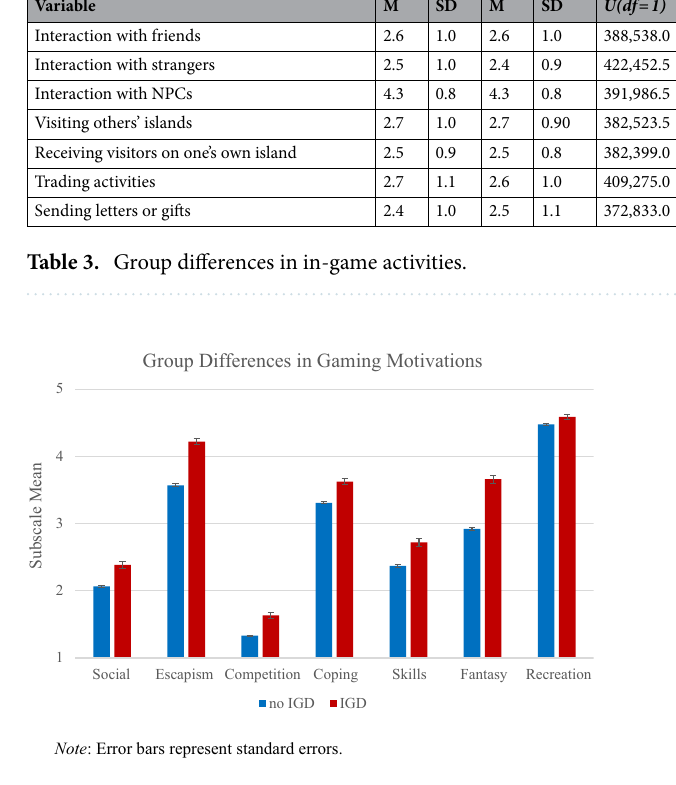
Figure 2. Gaming motivations as a function of group membership (recreational users vs. candidates for IGD) . Error bars represent standard